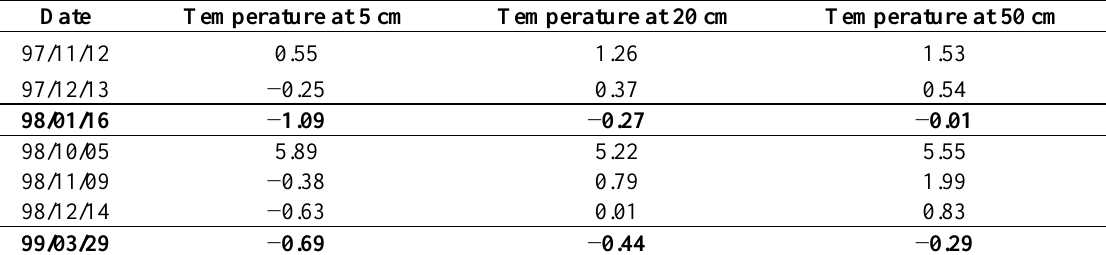
Table 2. The daily mean ground temperatures (°C) recorded at different depths near